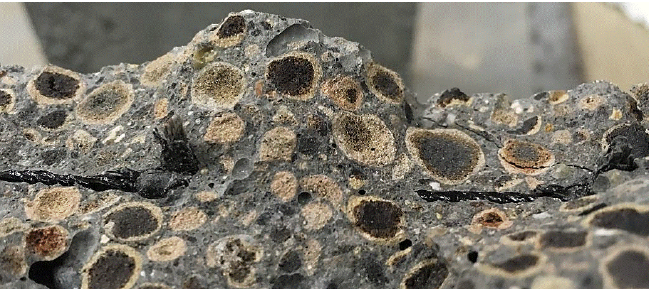
Table 3. Main properties of used aggregate.